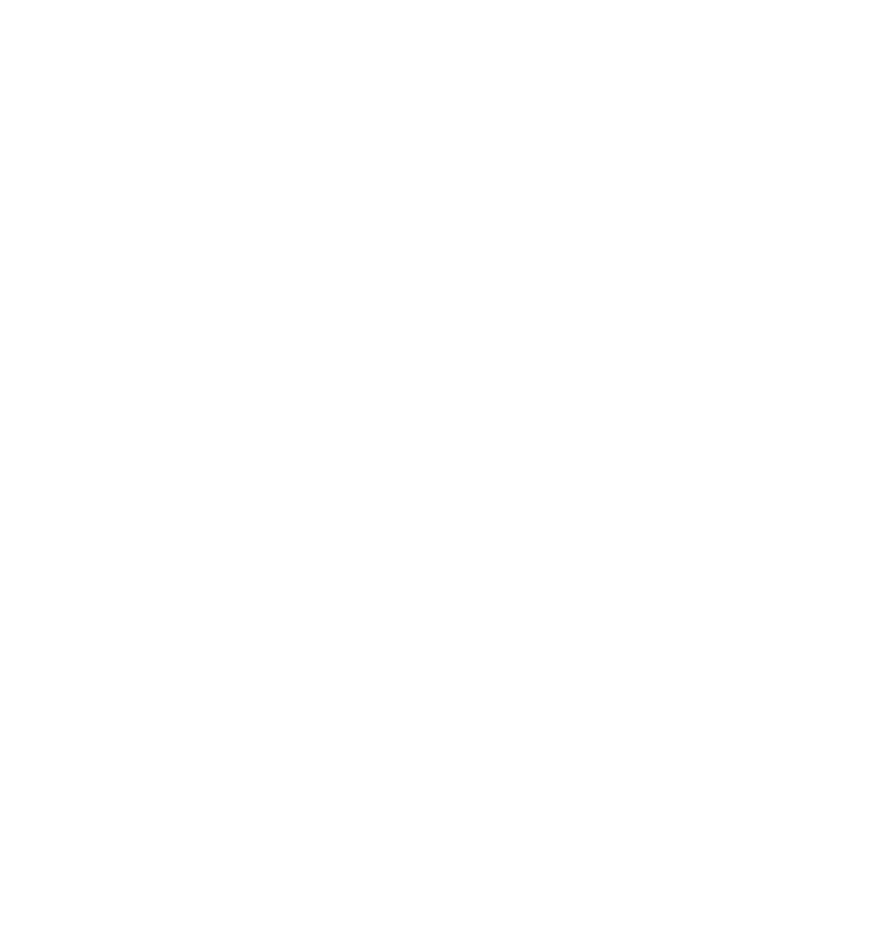
to Figure 7. The in-text citations to Figure 7 should be to Figure 8. The in-text citations to Fig- ure 8 should be to Figure 9. The in-text citations to Figure 9 should be to Figure 10. The in-text citations to Figure 10 should be to Figure